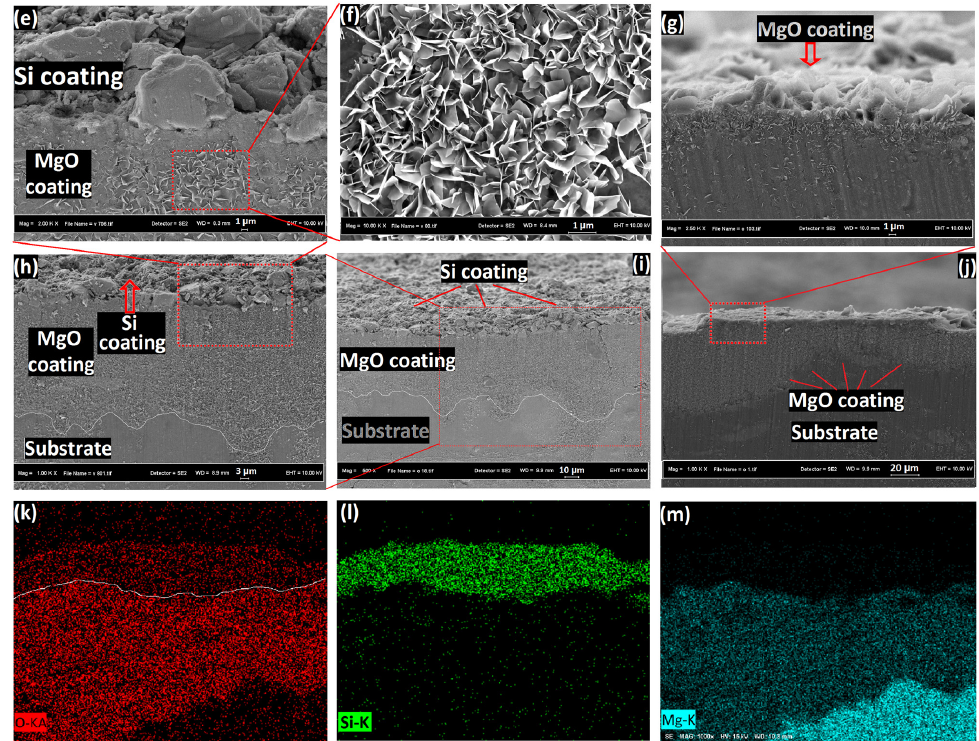
Figure 6. Transmission electron microscopy (TEM) images ( a ) Si particles, ( d ) MgO sheets, energy dispersive X-ray spectroscopy (EDS) analyses ( b ) area 1 and ( c ) area 2. Cross-sectional FE-SEM micrographs of ( e , f , h , i ) Si/MgO-coated, ( g , j ) MgO-coated and ( k , l , m ) X-ray elemental mapping of Figure 5h.